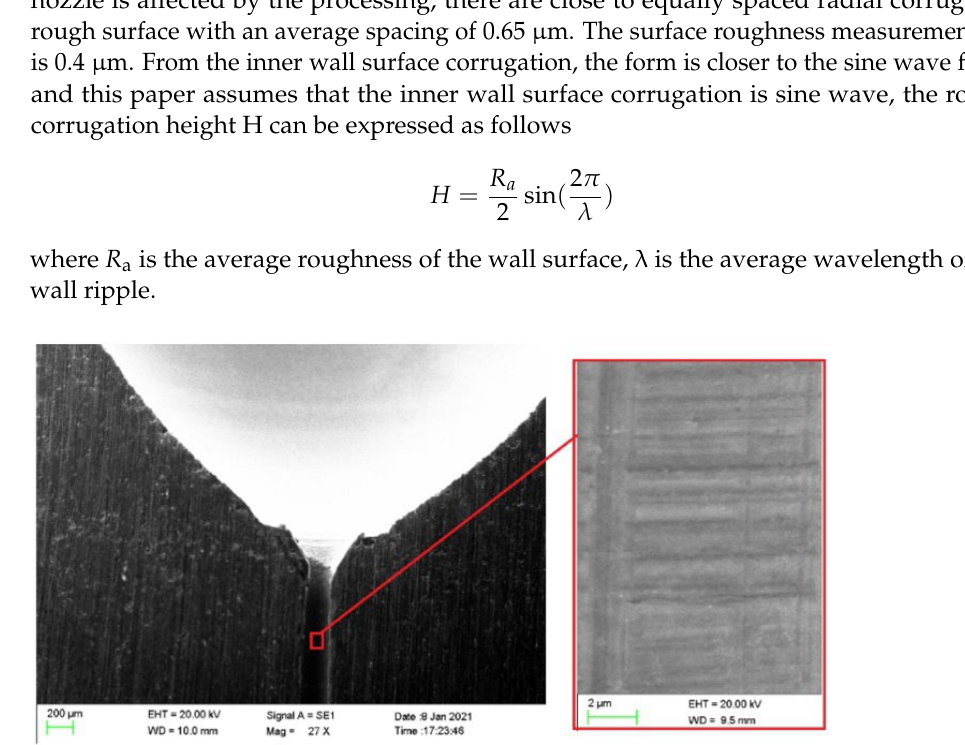
Figure 2. Scanning electron micrograph of inner surface of micro-nozzle.